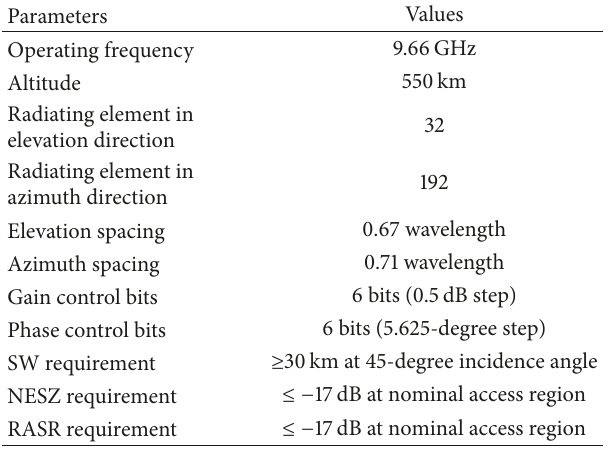
Table 3: Simulation parameters and system performance require- ments of